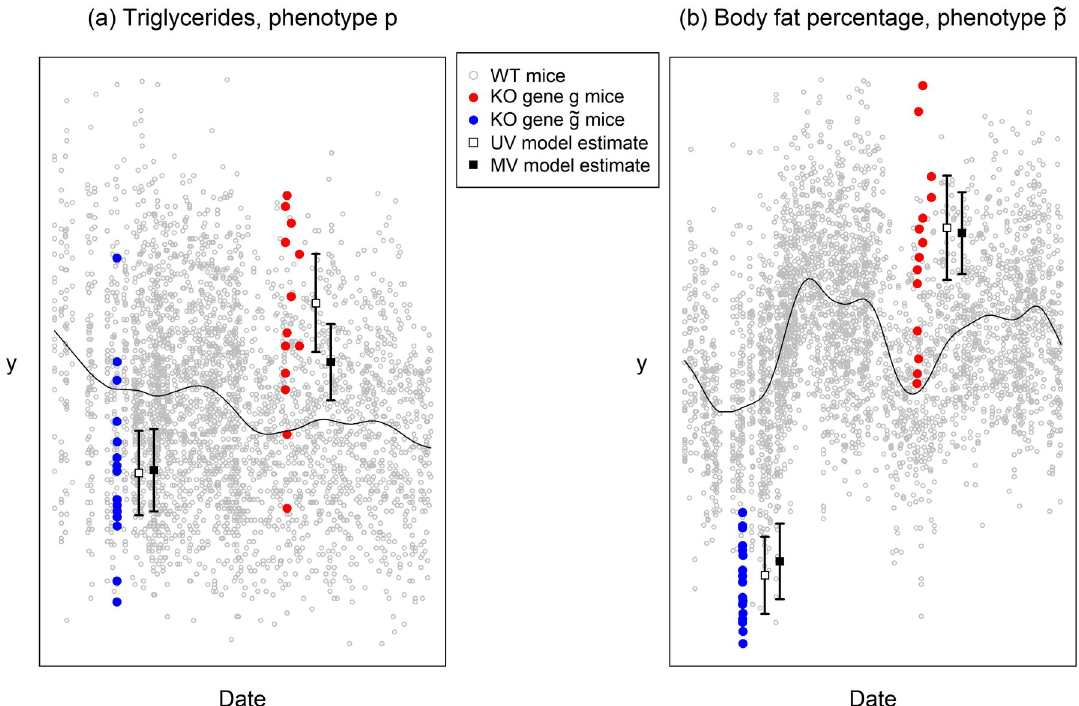
Fig 1. Experimental design of the IMPC. Each point corresponds to 1 animal, with data from 2 KO lines—labelled g and e g —displayed alongside contemporaneous data from a large number of control (wild-type, or WT) animals in grey (see legend). Panels (a) and (b) show data from phenotypes p (Triglycerides) and e p (Body fat percentage), respectively. Our goal is to quantify the underlying expected perturbations of the red/blue coloured points from the rolling WT baseline (illustrated with a smooth black curve), in the presence of structured experimental noise. Annotated on the plot, to the right of the red/blue measurement data of each gene–phenotype pair, are the posterior mean estimates from the UV and MV models, b y UV with empty squares and b y MV with filled squares (see legend), along with pg pg across multiple related phenotypes, such error bars denoting ± 2 posterior SDs. In the current paper, we combine the information in b y UV pg as p and e p , thereby generating improved estimators b y MV . The relative means and SDs of the UV and MV estimators shown in the plot pg are illustrative of their general properties—MV posterior means are shrunken towards zero (towards the black curve here) relative to the UV posterior means in 90.2% of cases (phenotype–gene pairs); while MV posterior SDs are smaller than UV posterior SDs in > 99.9% of cases. The data and code used to generate this figure are available at [13,14].IMPC, International Mouse Phenotyping Consortium; KO, knockout; MV, multivariate; UV, univariate; WT,